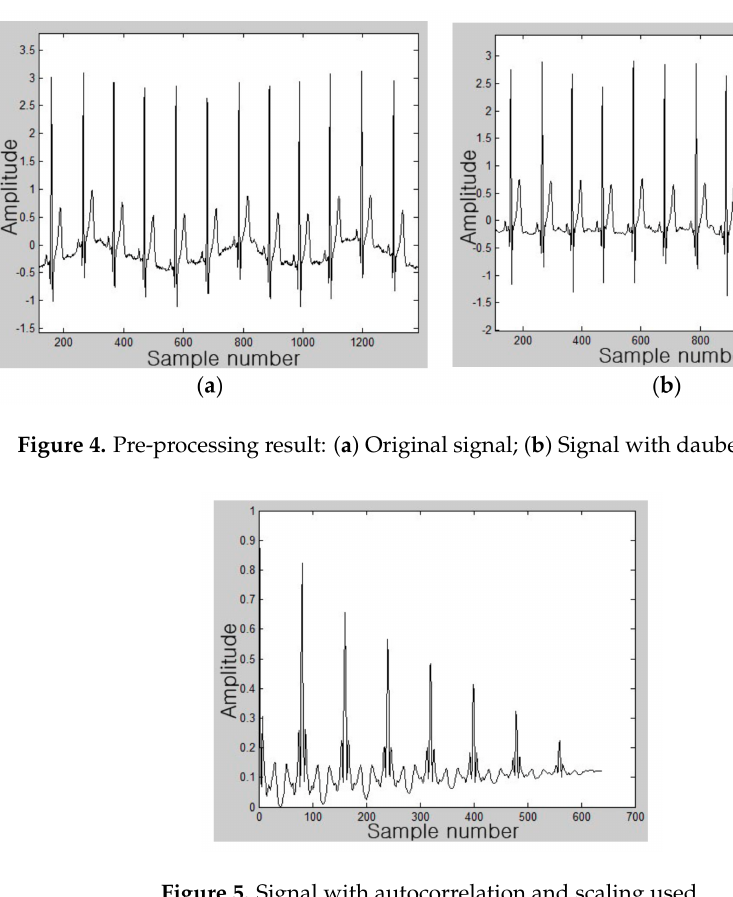
Figure 5. Signal with autocorrelation and scaling used.